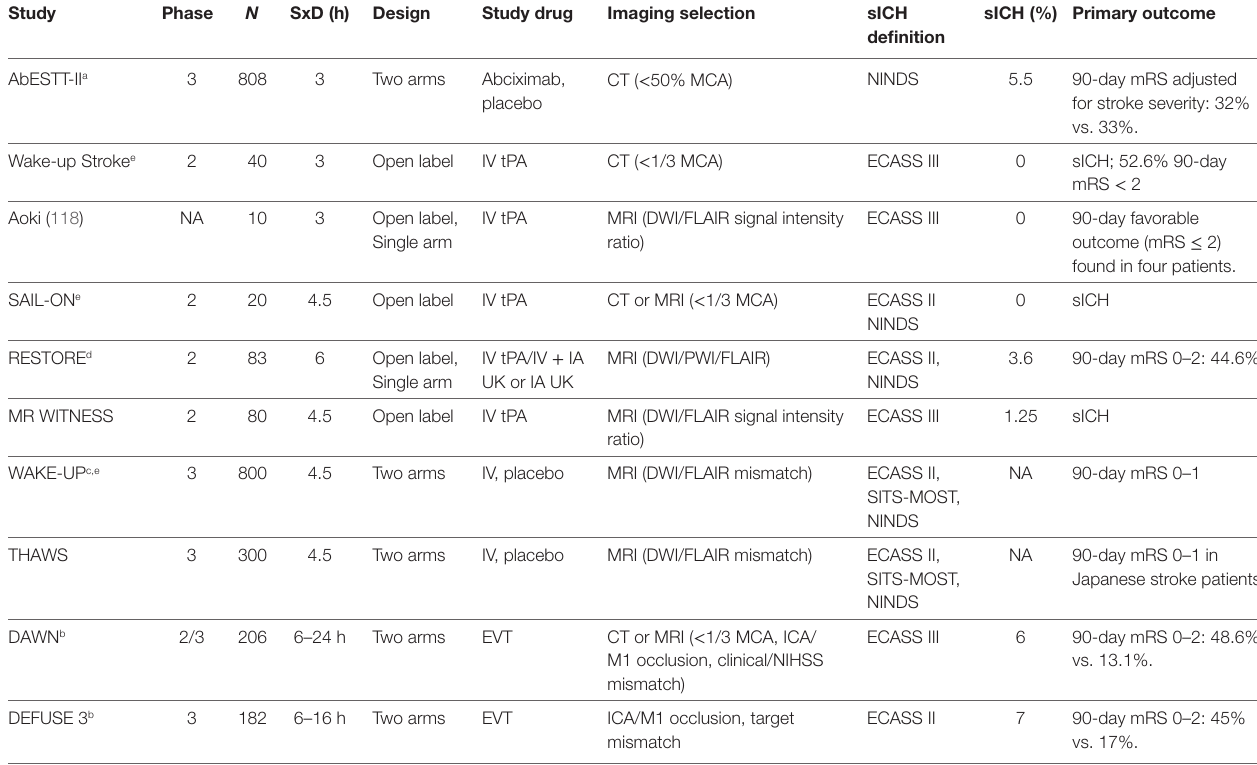
TABLe 3 | Prospective trials of thrombolysis in WUS and non-WUS SUSO patients.